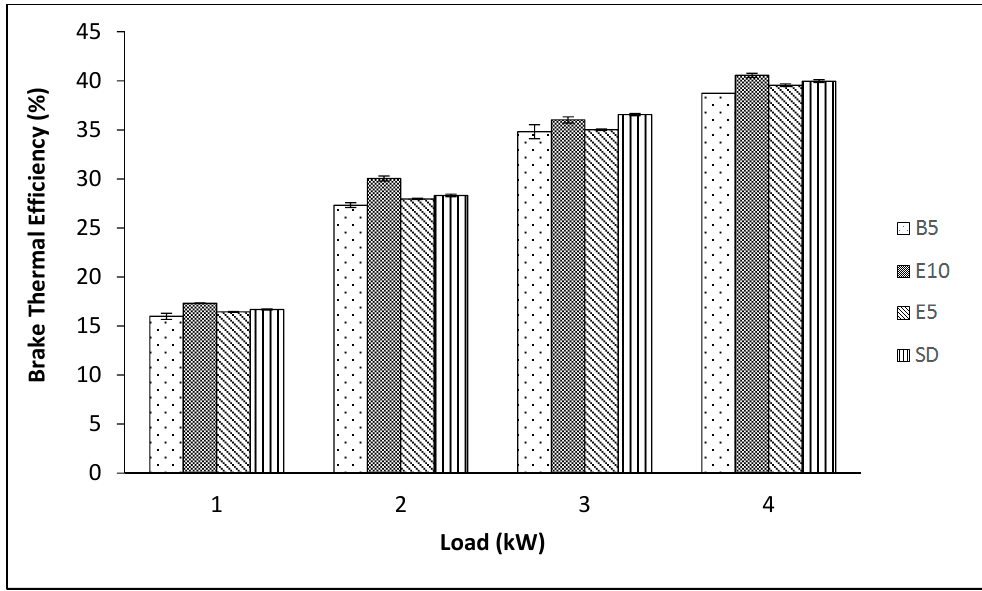
Figure 8. Brake thermal efficiency versus load.